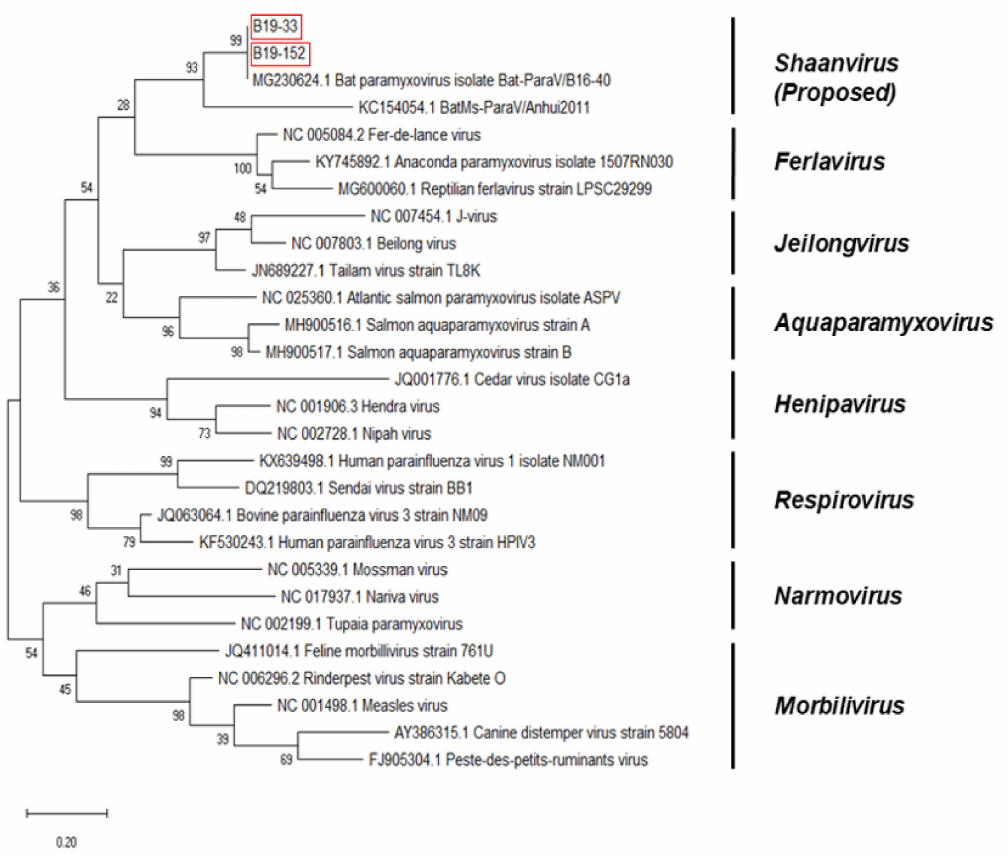
Figure 3. Phylogenetic analysis based on partial Fusion protein (F) nucleotide sequences of bat paramyxoviruses detected in Korean bats and other reference viruses belonging to Paramyxoviridae . The phylogenetic tree was generated via the maximum-likelihood method with 1000 replicates of bootstrap sampling and Kimura 2-parameter model using MEGA X. Korean bat paramyxoviruses are indicated by red